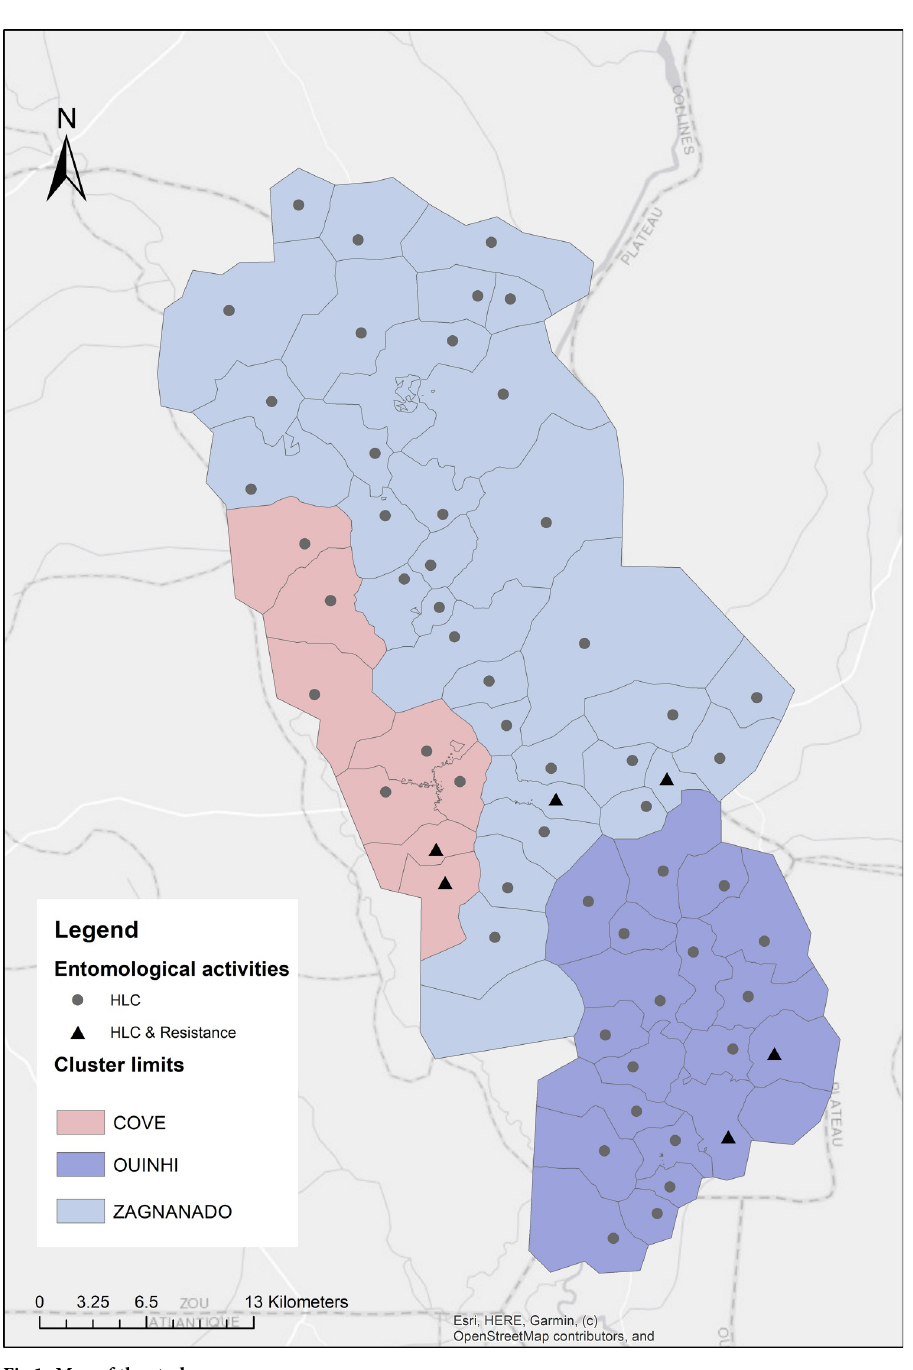
Fig 1. Map of the study